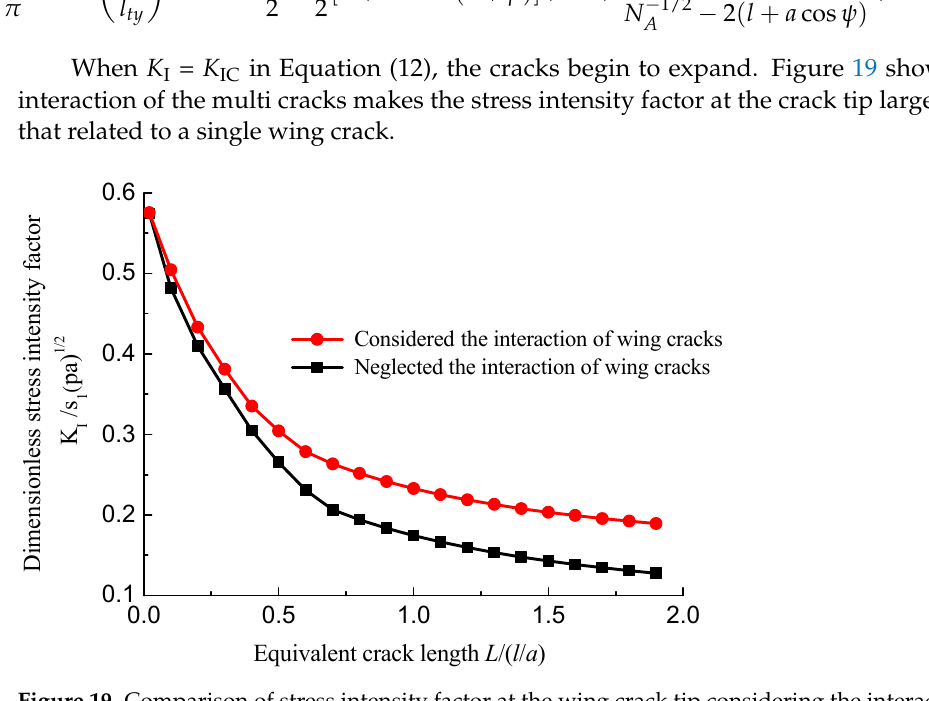
Figure 20. The relationship between crack initiation strength and crack angle.